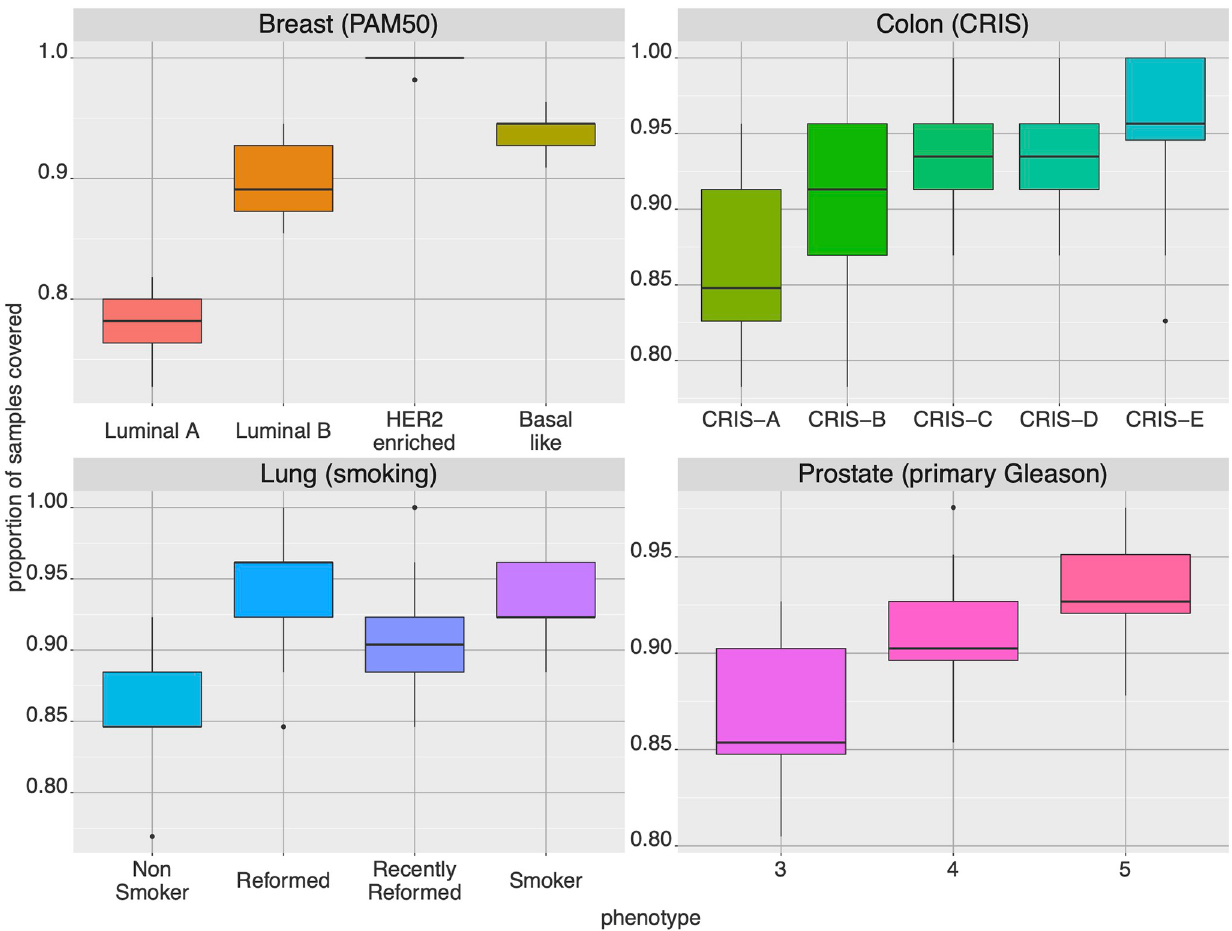
Fig 5. Rates of covering assembly. For each of four tissues (breast, colon, lung and prostate), several phenotypes are compared based on the proportion of samples actually covered when requesting 90% coverage or more for the given tissue by the optimization procedure. The boxplots represent the results of 20 iterations of normalizing for sample size among the phenotypes by random sampling. In general, coverings for more aggressive phenotypes assemble